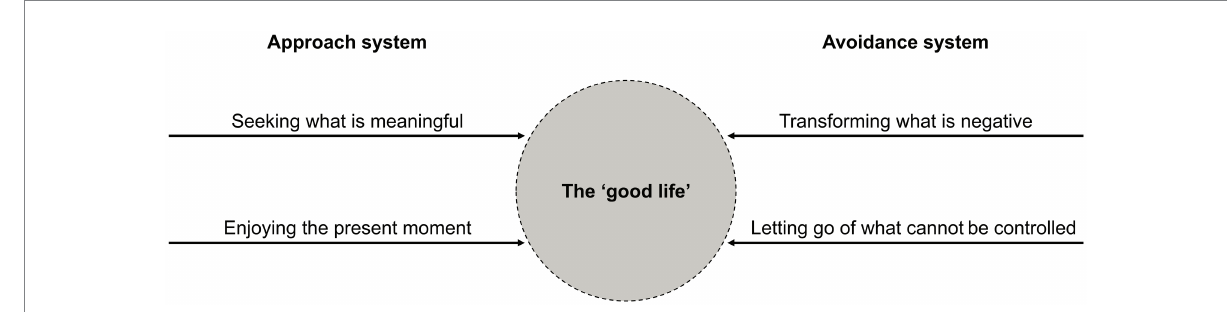
FIGURE 2 Visual illustration summarizing the dual-systems model reflecting the ‘good